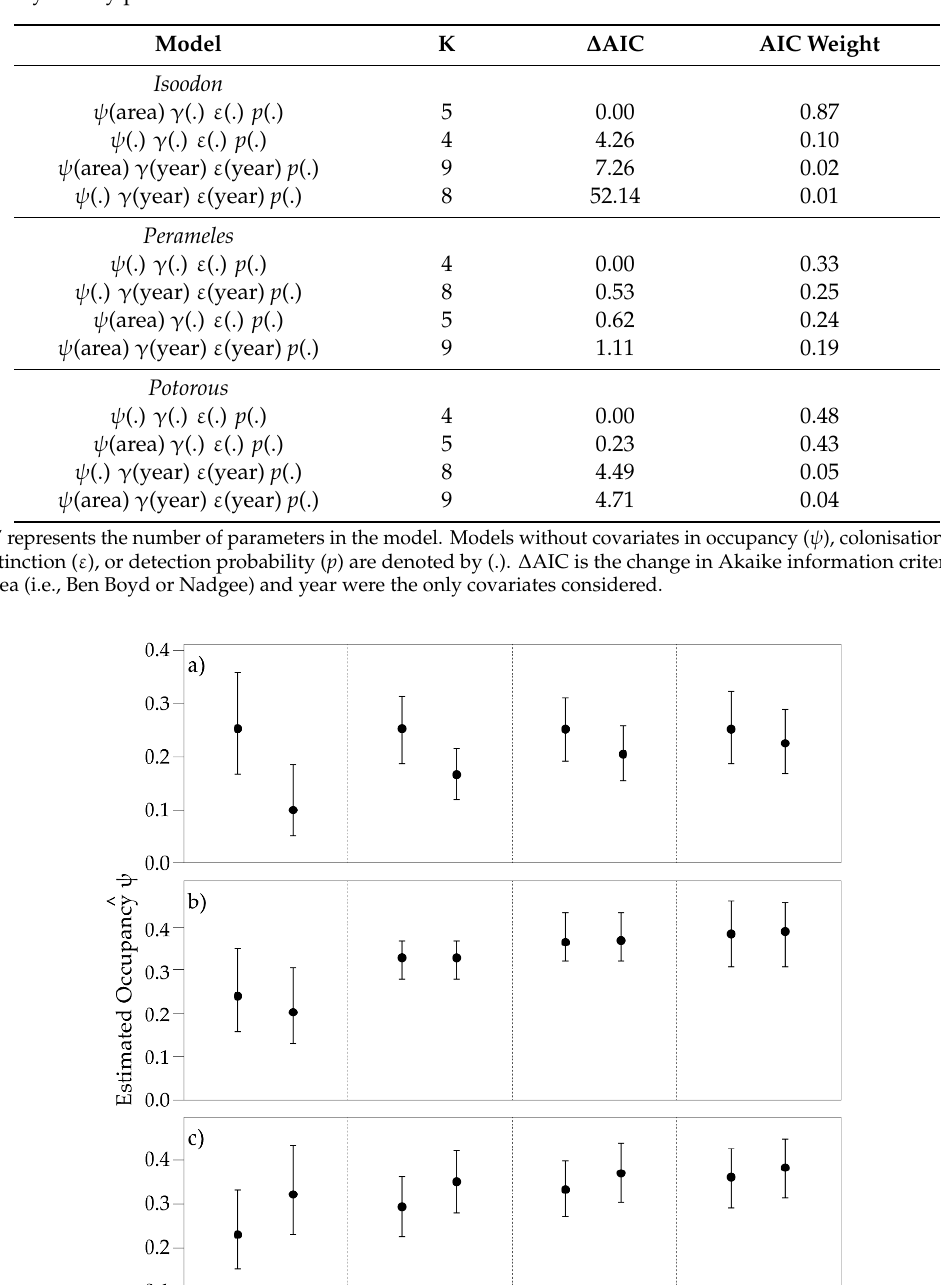
Table 6. Multi-season occupancy model selection results for Isoodon , Perameles and Potorous , based on 40-day survey period data.